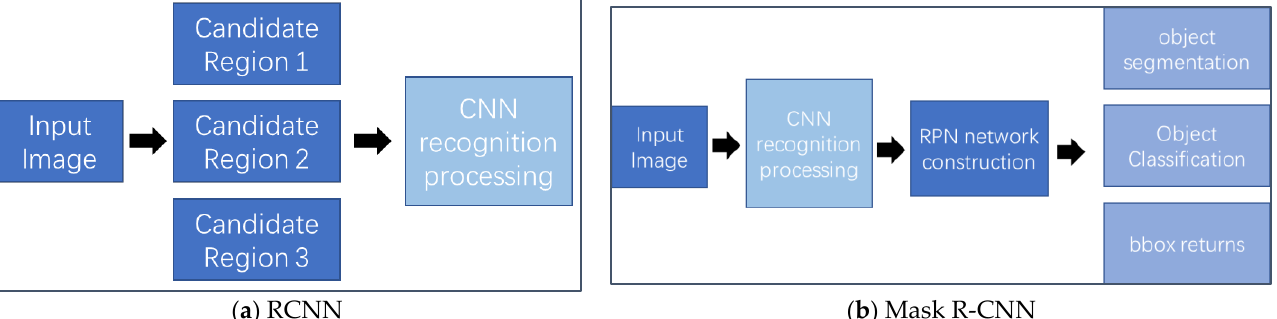
Figure 1. Working principles of RCNN and Mask R-CNN.